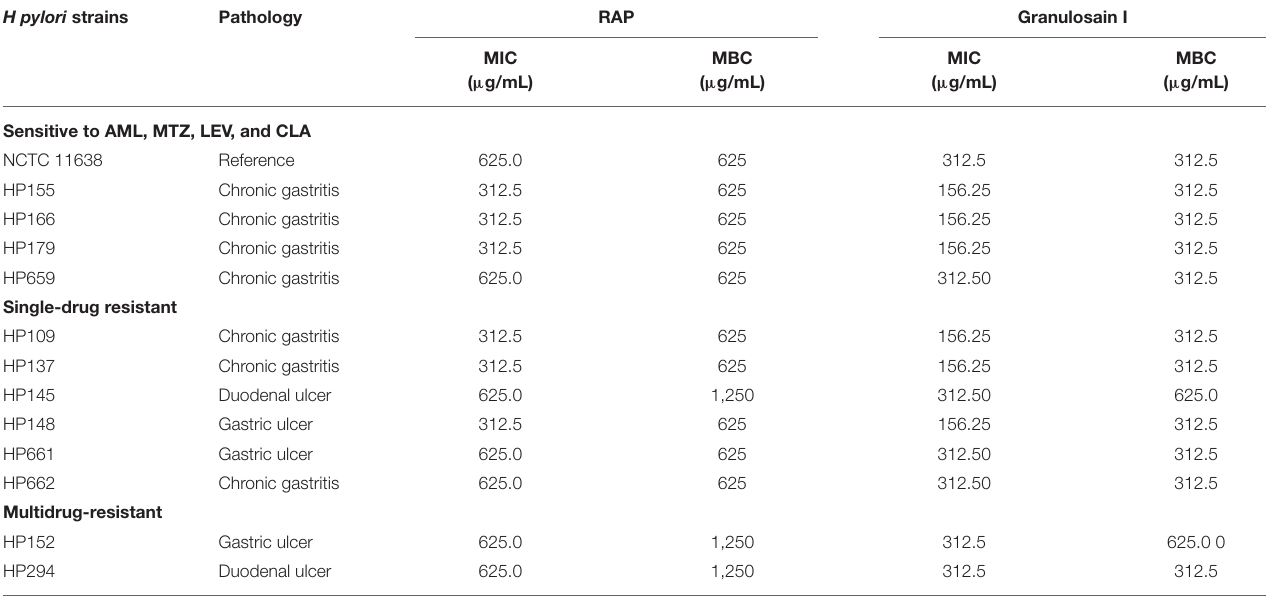
TABLE 3 | MIC and MBC of the partially purified proteolytic extract (RAP) of the fruits from Solanum granuloso-leprosum and its main purified fraction (granulosain I) against H. pylori strains by means of the broth microdilution method. H pylori